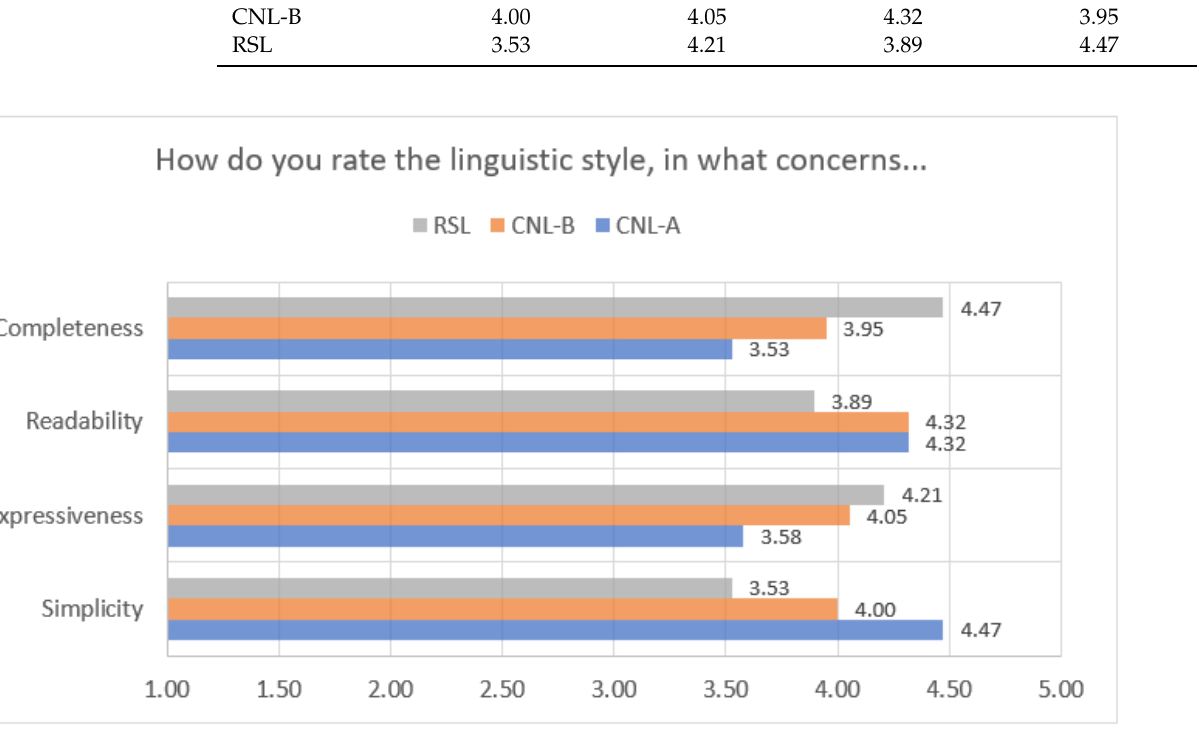
Figure 8. Bar-chart on how participants rate the linguistic styles (values in a 1–5